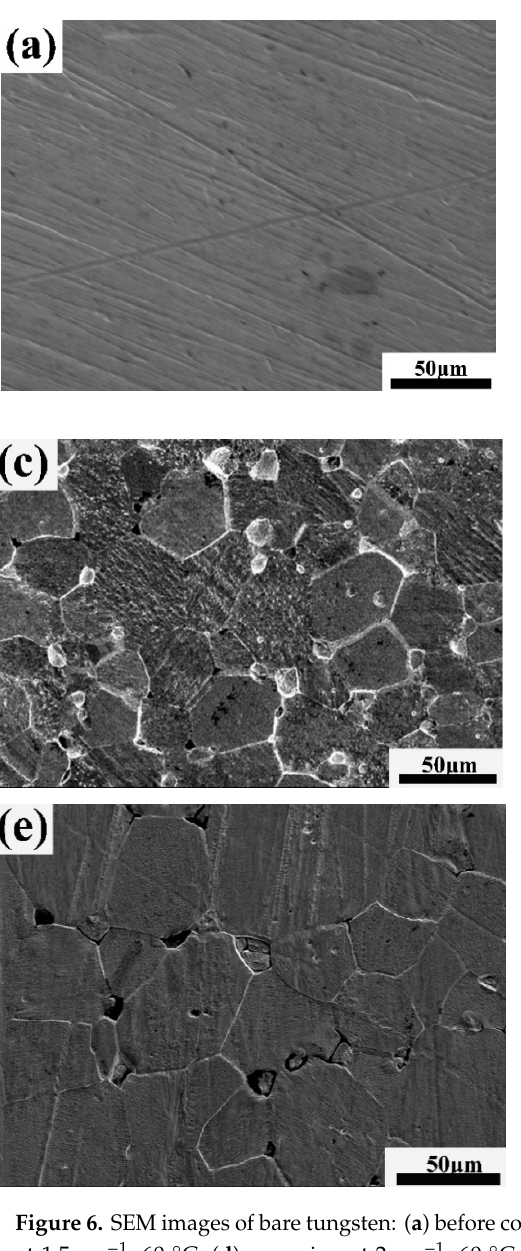
Figure 5. SEM image of the W–Cr–C coated tungsten samples (the red refers to the pores): ( a ) before corrosion; ( b ) corrosion at 1 ms −1 , 60 °C; ( c ) corrosion at 1.5 ms −1 , 60 °C; ( d ) corrosion at 2 ms −1 , 60 °C; ( e ) corrosion at 2 ms −1 , 20 °C; and ( f ) the bar chart of pitting fraction with velocity and temperature.